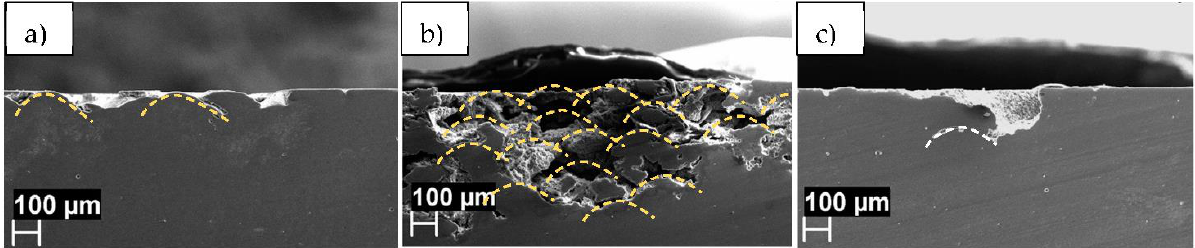
Figure 7. Morphology of corrosion after ISO 11846 test on AlSi10Mg LPBF samples ( a ) UT; ( b ) 2h-300; ( c ) 2h-400: the yellow dotted line underlined the edge of the melt pool that is preferentially corroded; the white dotted line in ( c ) evidences a porosity in the correspondence of the prior edge of the melt pool (after the heat treatment the melt pools disappeared). (Exposed area XY, section XZ).